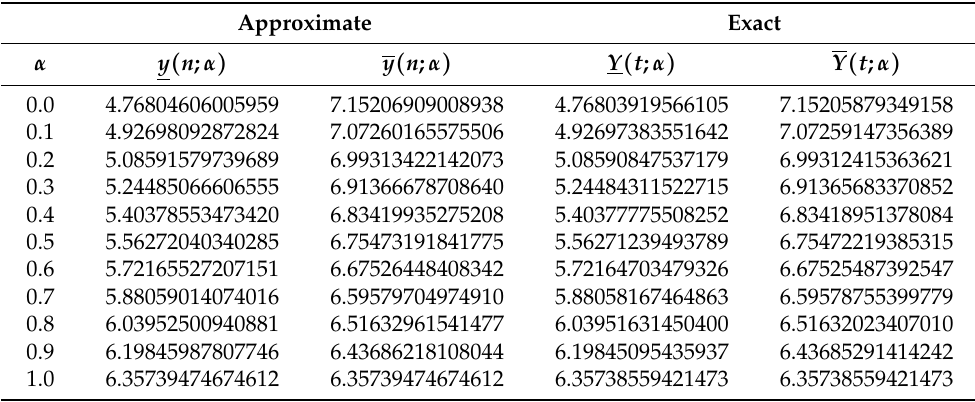
Table 1. Values of exact and approximate solutions by using the RK-4 method for the indicated